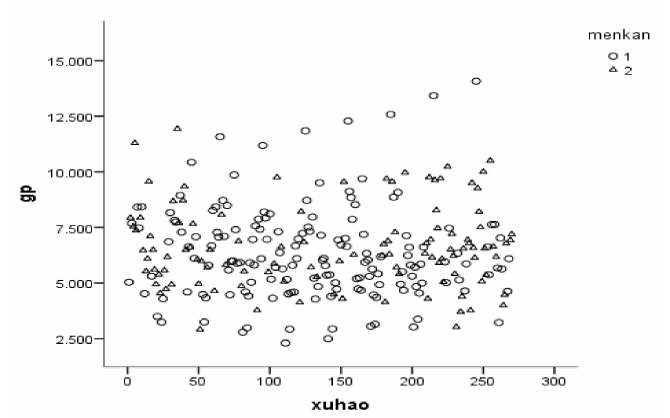
Figure 7. The sample distribution of the real income level under the two risk types of the health shocks of air pollution. Note: Level 1 represents the health shocks of the air pollution risk <1.9873, and level 2 represents ≥